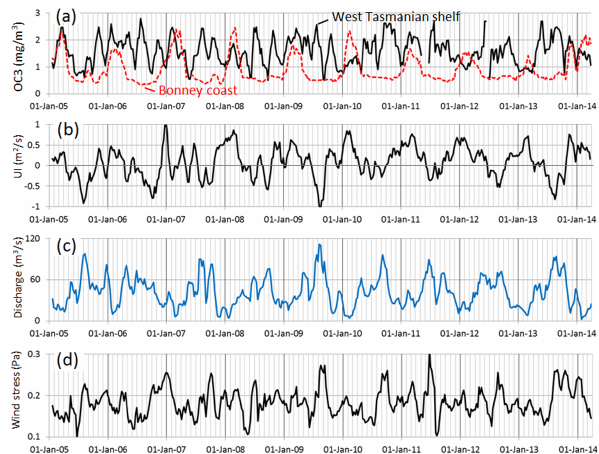
Figure 7. Time series (1 January 2005 to 31 March 2014) of (a) OC3, (b) upwelling index, (c) discharge from the Davey River and (d) wind stress. Data were first converted to 8-day segments and then smoothed with a running average over three segments. For comparison, panel (a) includes data for the Bonney coast. Data sources: NASA (Giovanni), Bureau of Meteorology (Australia) and Water Information System of